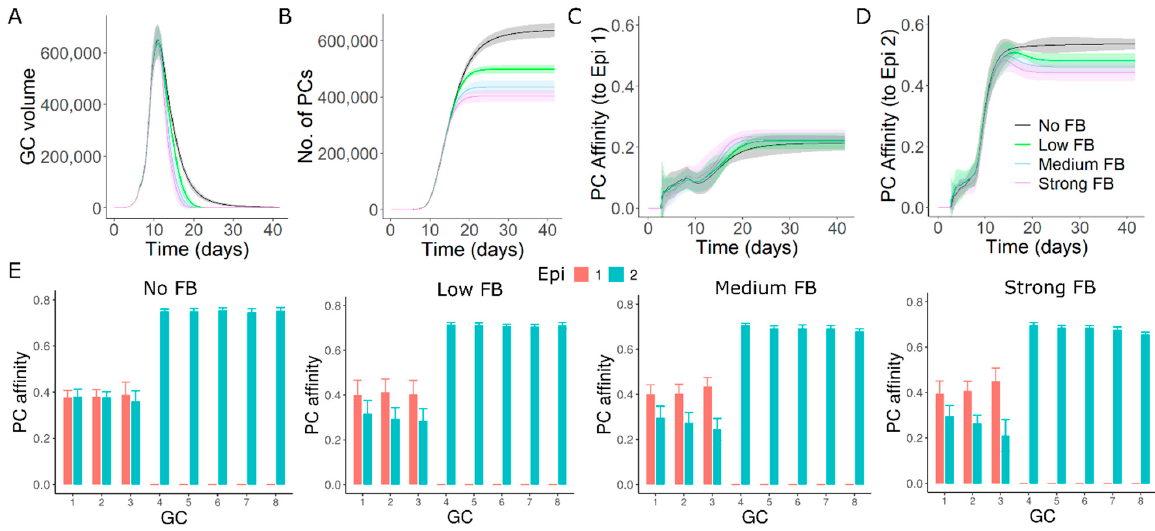
Figure 5. Interaction of GCs with different founder cell compositions. ( A ) Total volume of all GCs. ( B ) Plasma cell production from all GCs. ( C ) Affinity of plasma cells from all GCs to Epi 1. ( D ) Affinity of plasma cells from all GCs to Epi 2. Readouts in ( A – D ) represent the sum of corresponding readouts of all simulated GCs weighted by the number of non-explicitly simulated GCs in each case. ( E ) Affinity of plasma cells from individual GCs to different epitopes with different GC–GC interaction strengths (No FB, Low FB, Medium FB and Strong FB). GCs were simulated asynchronously initialized with two epitopes (shape space positions 2222 and 6666) in equal proportion. Founder cells of GCs 1–3 were chosen randomly anywhere in the shape space and founder cells of the rest of the GCs were chosen at a distance of 1 mutation from shape space position 6666. GCs 1–8 were sorted in the sequence of initiation. 3.7. Persistent Addition of Antigen Can Overcome the Effects of GC–GC Interactions Antibody-mediated decrease in the longevity of GC responses and output production might act as a self-regulatory mechanism that is limiting the magnitude of GC